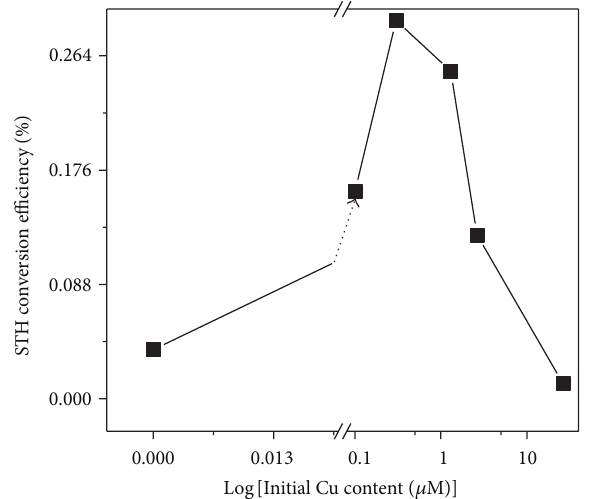
Figure 6: STH conversion efficiency of the doped ZnO films with different doping concentrations in the range 0–26.4 𝜇